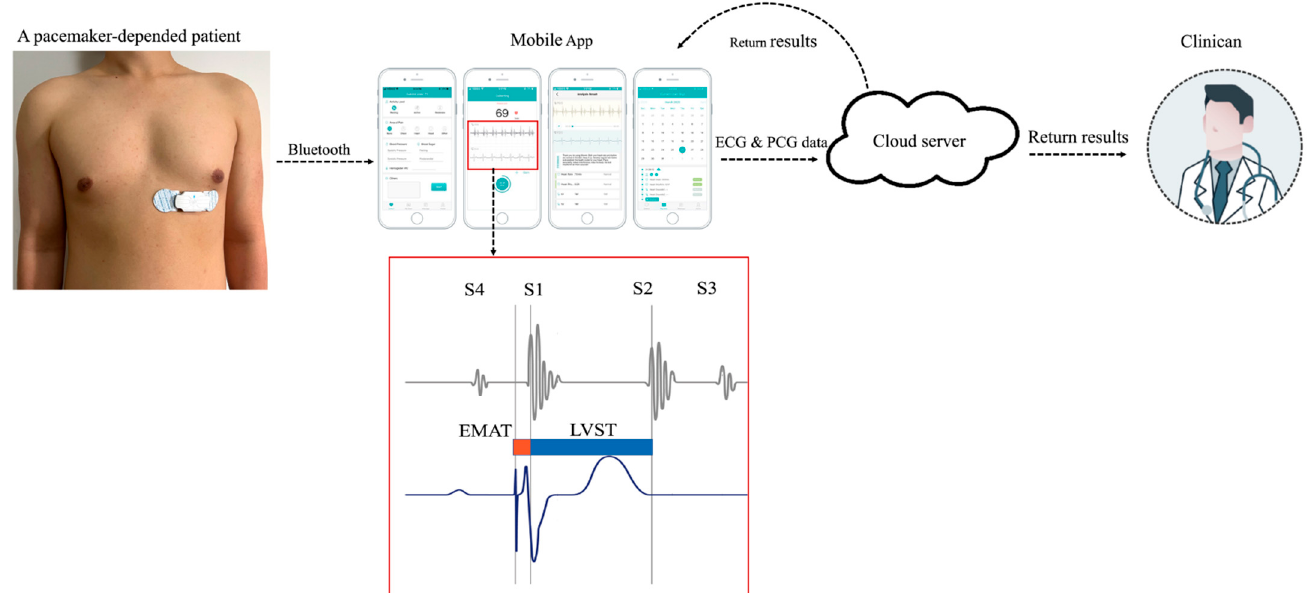
Figure 1. Illustration of the WENXIN ® device on patient with pacemaker. The typical relationships between ECG and cardio-hemic vibrations recorded are summarized.